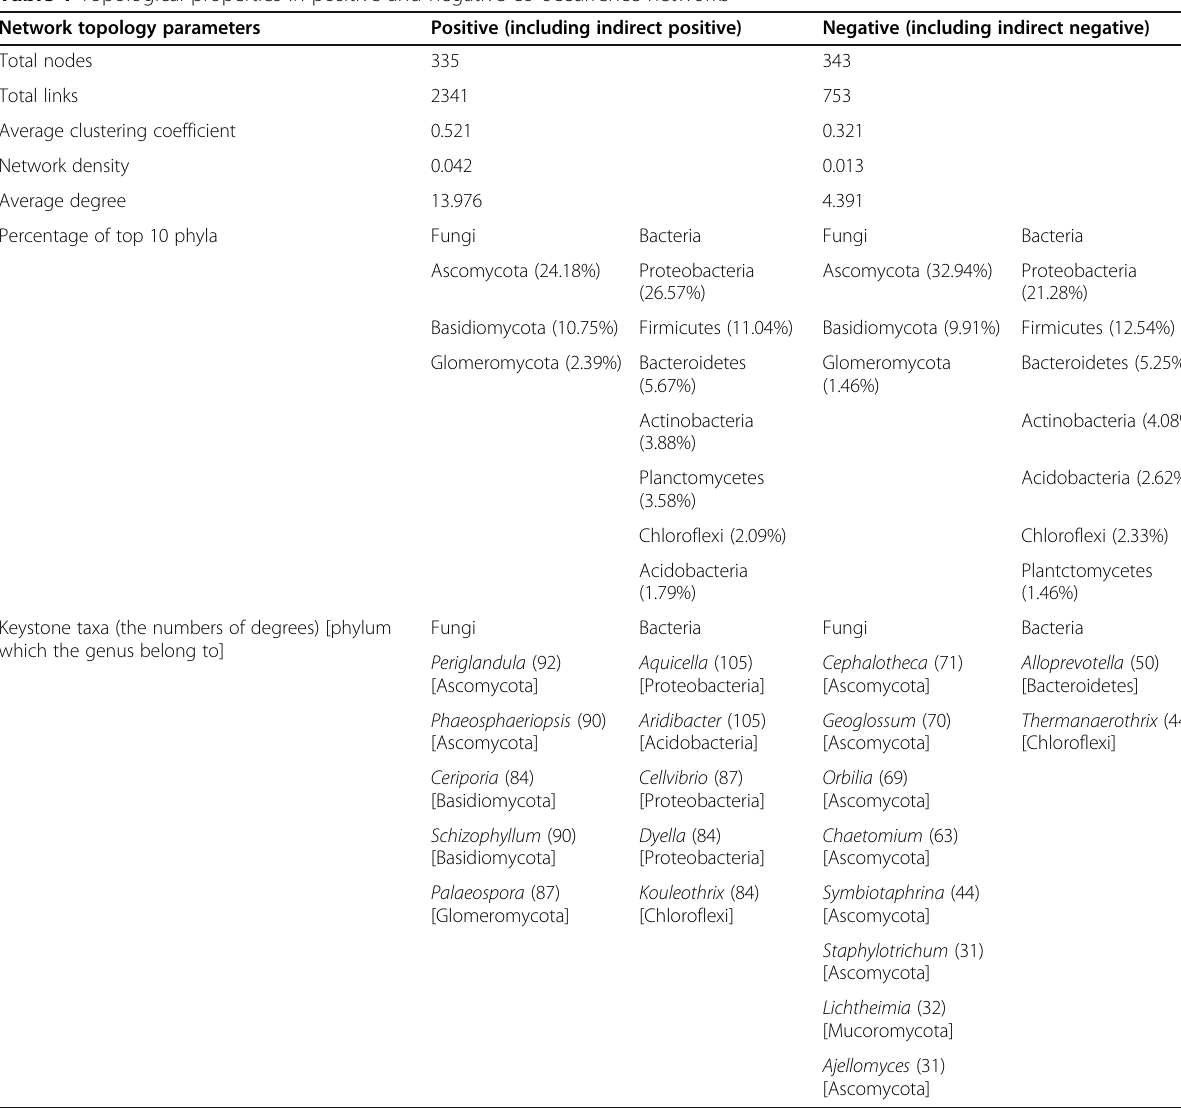
Table 1 Topological properties in positive and negative co-occurrence networks Network topology